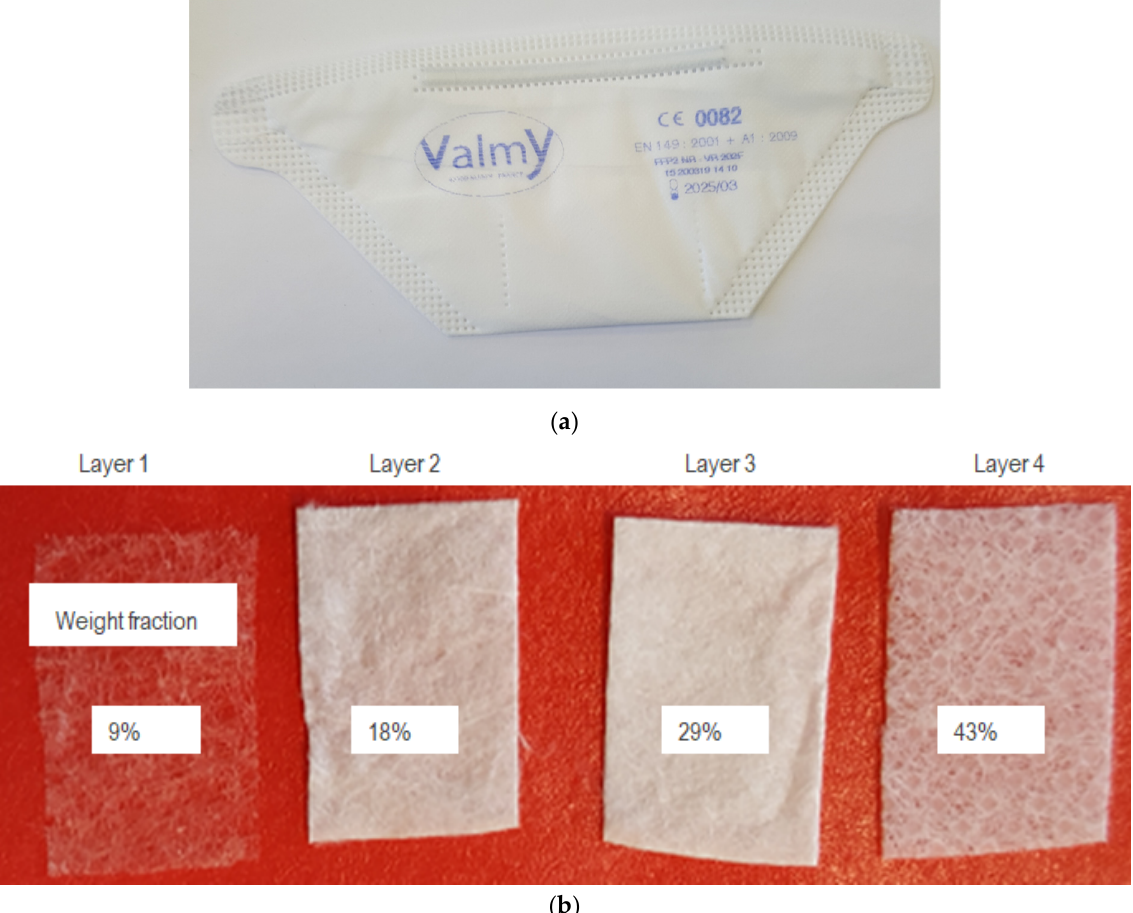
Figure 1. Picture of the Valmy FFP2 medical mask ( a ). The four layers of material (Layer 1: internal face; Middle: filter; Layer 4: external face). ( b ) The data for elastic strap are not presented in the main body of the article but its characterization was realized (see Figures S1–S4 of the Supplementary Materials).